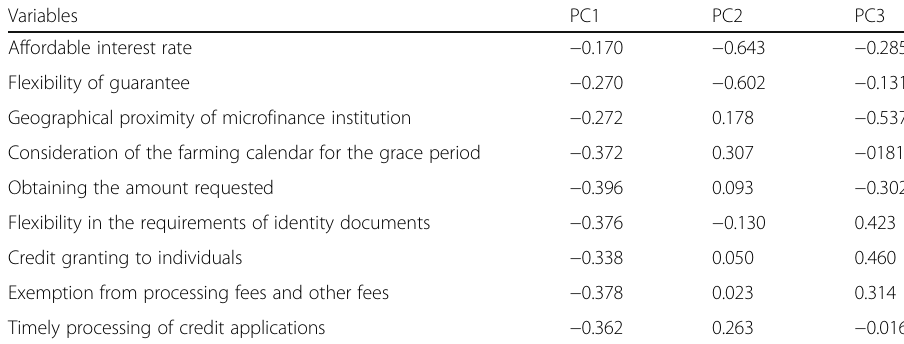
Table 4 Correlation between principal components (PC) and original variables Variables PC1 PC2